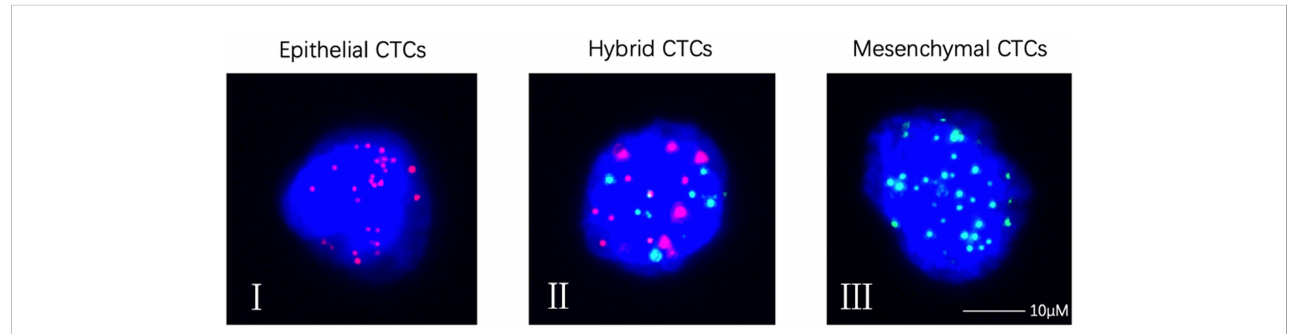
FIGURE 2 Representative images of CTCs with RNA-ISH method. (I) Epithelial CTCs stained for epithelial markers (EpCAM and CK8/18/19, red fl uorescence); (II) Hybrid CTCs stained for epithelial markers (EpCAM and CK8/18/19, red fl uorescence) and mesenchymal markers (vimentin and Twist, green fl uorescence); (III) Mesenchymal CTCs stained for mesenchymal markers (vimentin and Twist, green fl uorescence). CTCs, circulating tumor cells. Each experiment was repeated for three times and each group had four replicates.